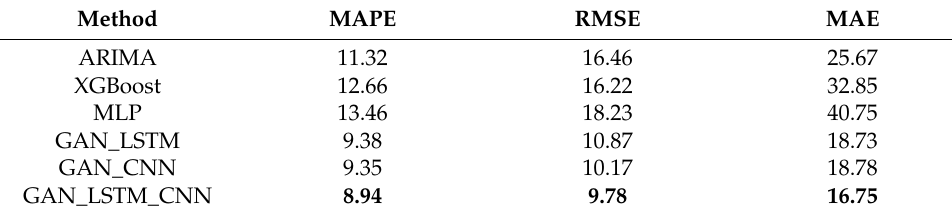
Table 7. Performance Comparison Guanggu